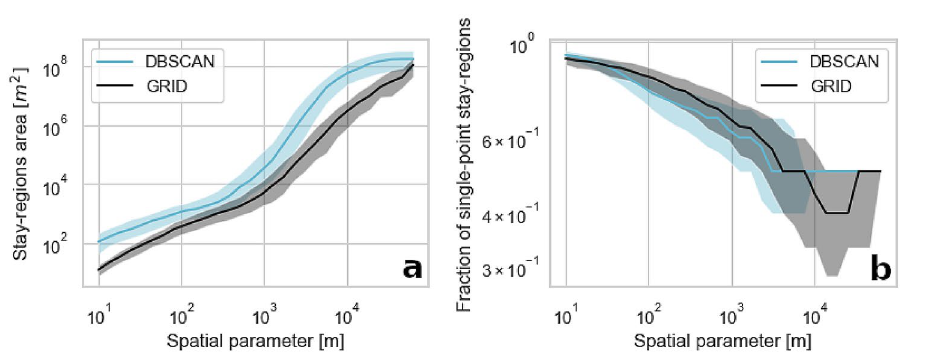
Figure 3. A dependence between the spatial aggregation method and the stay-regions area ( a ) and the fraction of single-point stay-regions ( b ). The lines represent the median value and the shaded area indicate the interquartile range of the measure calculated for all the stay-regions in the dataset. Spatial parameter relates to the variable controlling the magnitude of spatial aggregation in the grid-based approach (grid resolution) and the DBSCAN ( ǫ parameter) method.